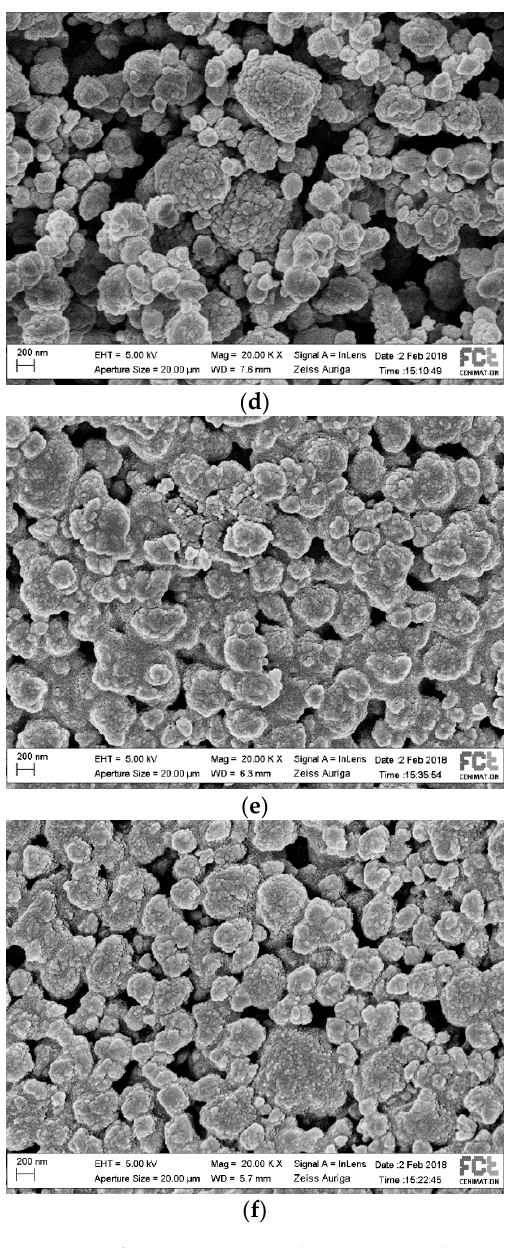
Figure 4. SEM images of the ZSM-5 extrudates at 40 × magnification: ( a ) sample 5, ( b ) sample 7, and ( c ) sample 8. SEM images of: ( d ) the ZSM-5 powder and extrudates of ( e ) samples 7 and ( f ) 8 at 20,000 × magnification. Table 2. Textural results for best formulation compositions.